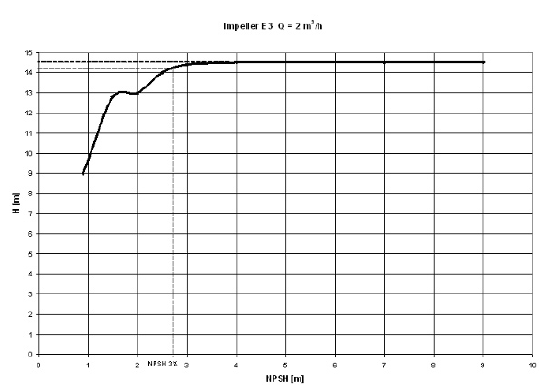
Figure 3. The cavitation characteristic with double elbow for the im- peller E3 and Q = 2m 3 /h.